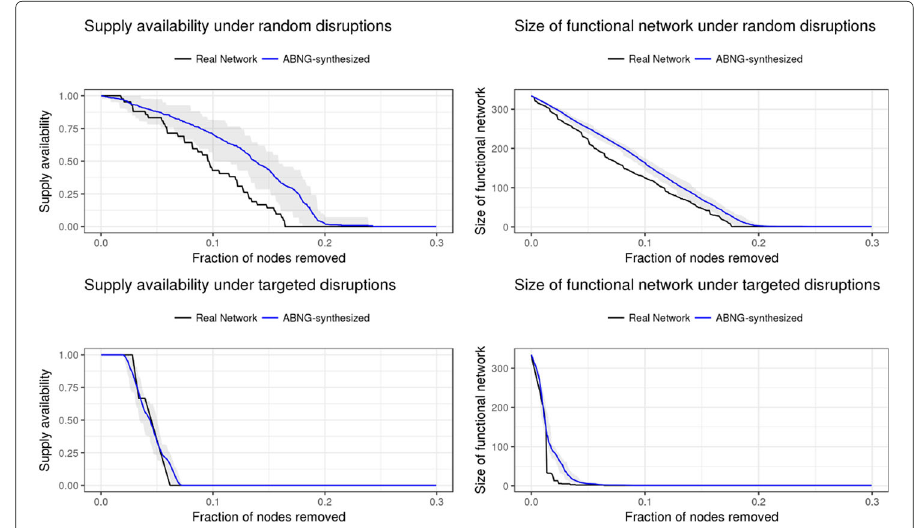
Fig. 6 Supply network of power-driven